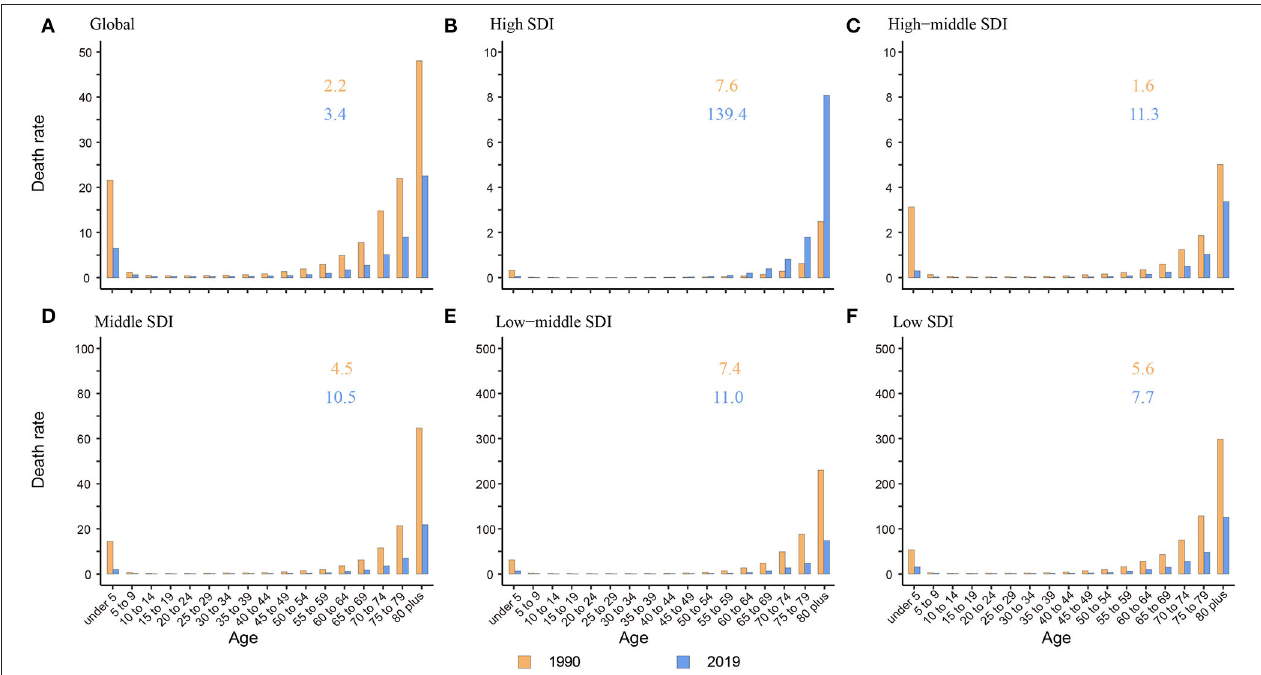
FIGURE 3 | The death rate of NADs among children under 5 and elderly over 80 globally and in 5 SDI regions. (A) Global; (B) High SDI; (C) High-middle SDI; (D) Middle SDI; (E) Low-middle SDI; (F) Low SDI. The orange and blue numbers above the column denote the ratio of elderly over 80 years old to children under 5 years old in 1990 and 2019 separately.